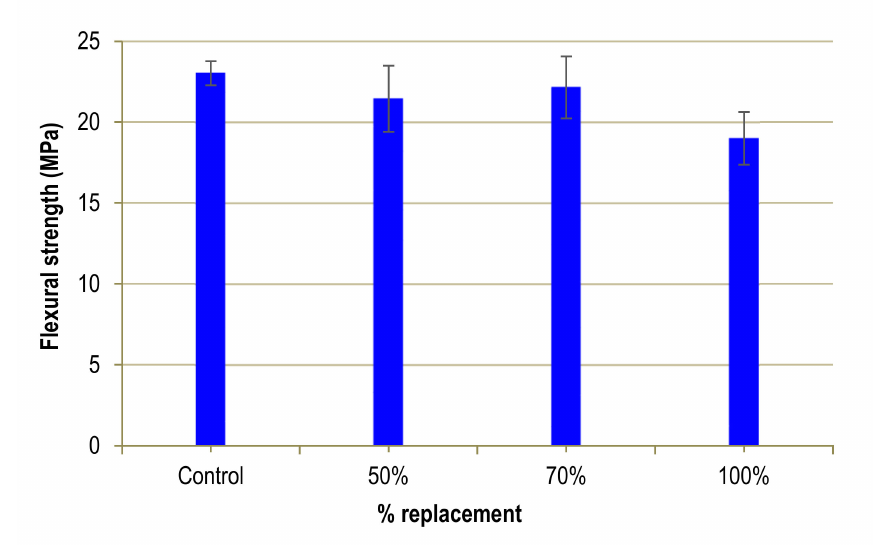
Figure 8. Flexural strength of UHPFRC.